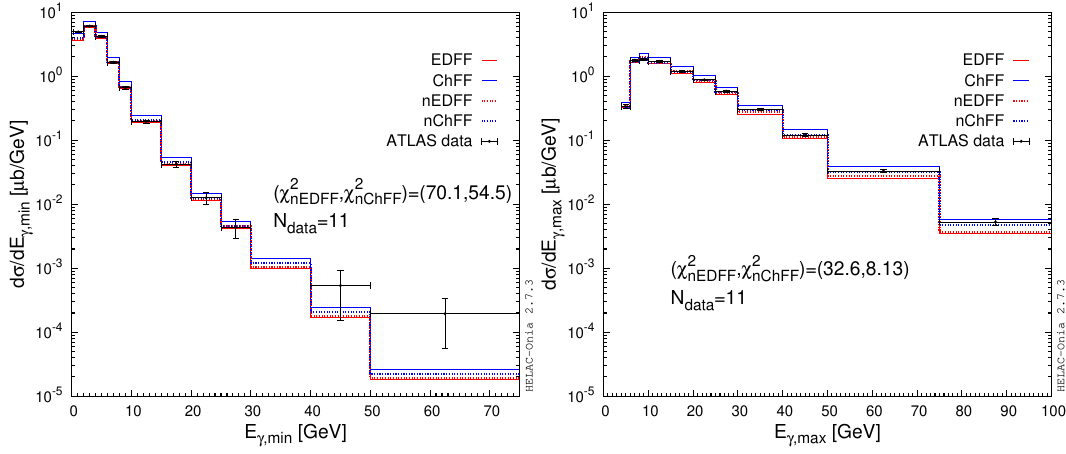
Figure 10 . Di (cid:11) erential cross section in terms of minimum (left) and maximum (right) initial photon energies in exclusive dimuon production in Pb-Pb UPCs at gamma-UPC predictions normalized (nEDFF and nChFF) and not (EDFF and ChFF) to the measured fiducial cross sections. Data-theory (cid:31) 2 values are quoted for nEDFF and nChFF fluxes